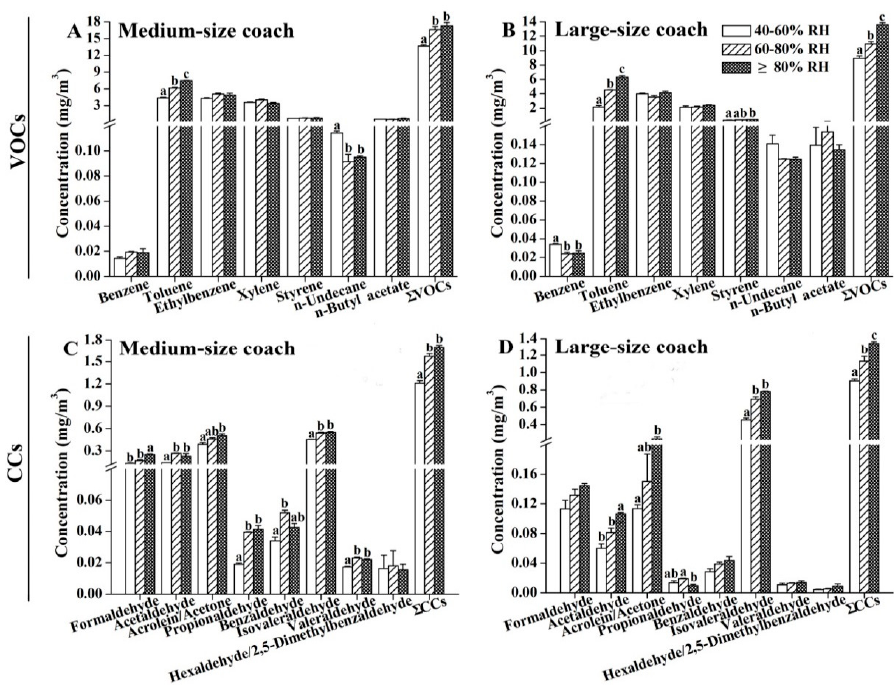
Figure 6. Emissions of organic compounds under different relative humidity (RH). ( A , B ) Levels of VOCs in the tested air samples; ( C , D ) Levels of CCs in the tested air samples. Interior temperature during sampling was 25 ± 2 °C. The results are expressed as the mean ± SEM. Values labeled with different letters are significantly different from each other at p < 0.05.